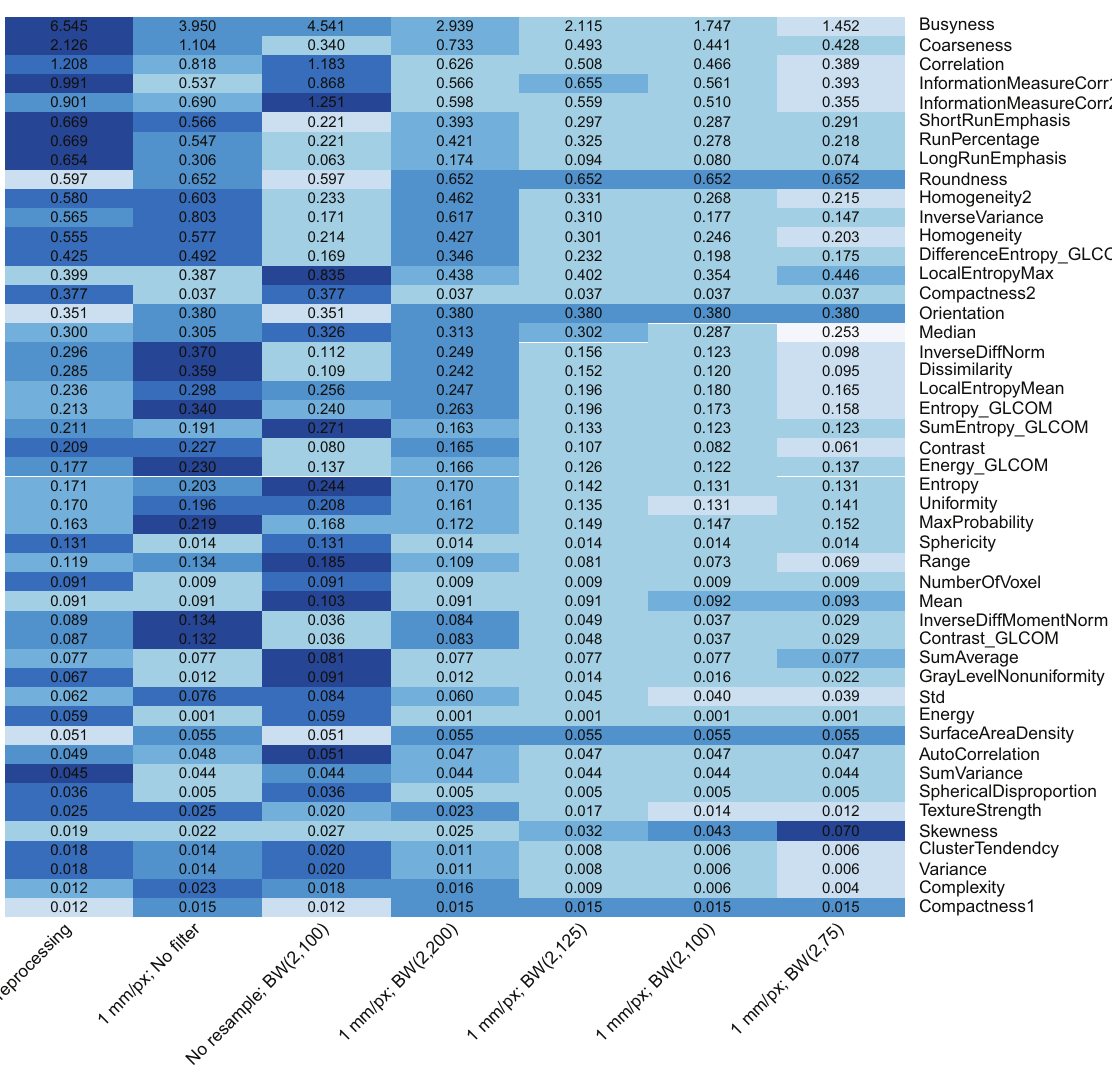
Fig 5. Heat map comparing the scaled variability for the 7 pixel size correction levels for the dense cork cartridge of the CCR phantom. The features were calculatedfor the phantomfor 17 scans. The color is rescaled on a row-by-row basis; darker colors indicatemore variability. The values in the cells are the scaled variability values. BW indicatesButterworth; px, pixel.